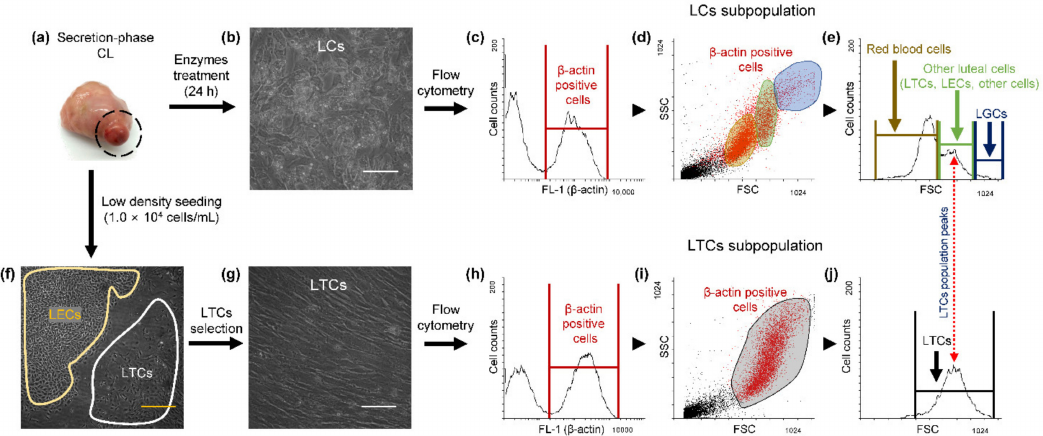
Figure 1. Isolation of bovine luteal theca cells (LTCs) and detection of morphology using flow cytometry. The corpus luteum (CL) tissues (( a ), black cycle) were used at 12–15 days after ovulation and luteal cells (( b ); LCs) and LTCs (( f ), white area, and ( g )) were used for experiment. The LCs and LTCs were stained by β -actin antibody conjugated with conjugated to fluorescein (FITC) dye to distinguish debris from the LCs ( c , h ). The subpopulation of β -actin-positive LCs (( d ), red dots) were largely classified into three areas: red blood cells (( d ), yellow area), other luteal cells (( d ), green area) and luteal granulosa cells (LGCs; ( d ), blue area). The relative size of the LCs was analyzed using histogram data of flow cytometry ( e ). The subpopulation of the β -actin-positive LTCs (( h , i ), red dots) was observed. The maximum peaks of x -axis of LTs ( e ) and LTCs ( j ) histogram data were matched (Red arrow). White scale bar: 100 µ m and yellow scale bar: 400 µ